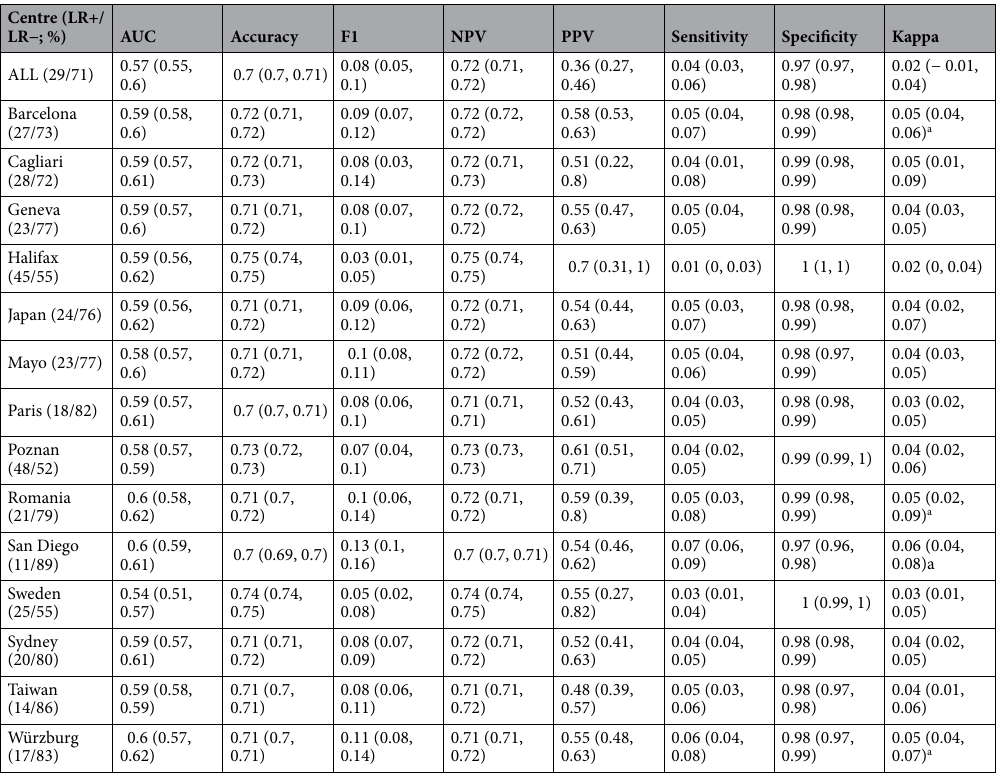
Table 4. The results of the logistic regression (LR) classifier in the leave-one-site-out analyses. Table columns represent different classification statistics and values represent the mean of each statistic over five folds along with an empirical 95% confidence interval. The center column shows the center that was left out for each row. We have included the results of the aggregate analysis in the top row for ease of comparison. In the column listing respective centres, we have included the percentage of lithium responders (LR+) and non-responders (LR−) in the format %LR+/%LR− to provide context for the classification results. Asterisks signify that the given metric was found to have a p value less than 0.01 compared to the simulated null classifier. Abbreviations: area under the receiver operating characteristic curve (AUC), positive predictive value (PPV), negative predictive value (NPV), F-1 score (F1). a Kappa value was found to have a p value less than 0.01 in comparison to the null classifier.